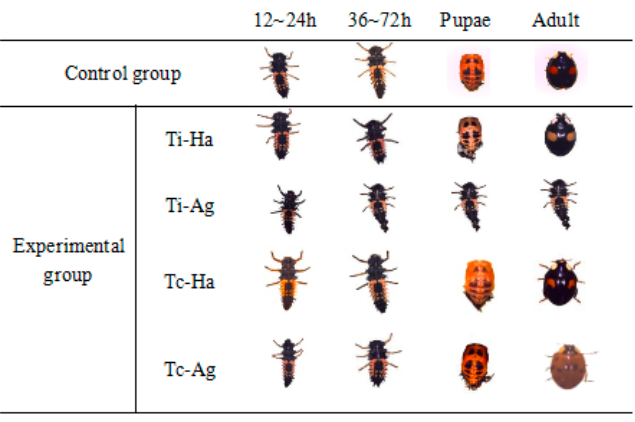
Figure 1. Development and phenotypic changes in ladybirds after different treatments. Control: 4th instar larvae with 12 h starvation + fed on aphids; Ti-Ha represents imidacloprid-treated H. axyridis + common aphids ; Ti-Ag represents imidacloprid-treated aphids + common H. axyridis ; Tc-Ha represents chlorpyrifos-treated H. axyridis + normal aphids ; Tc-Ag represents chlorpyrifos-treated aphids + normal H. axyridis .